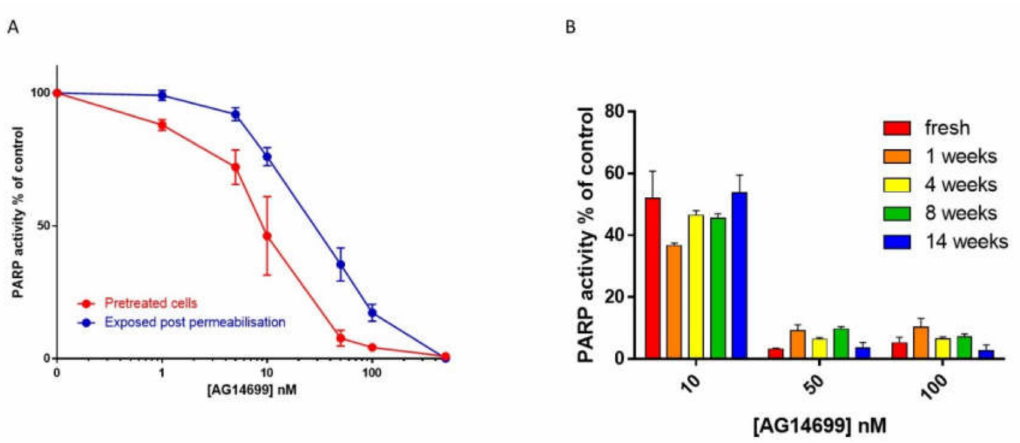
Figure 2. Inhibition of cellular poly (ADP-ribose) polymerase (PARP) activity. ( A ) PARP inhibition by increasing concentrations of AG14699 (rucaparib) following pre-treatment of L1210 cells (30 min) with drug prior to harvesting (red symbols and line) compared with drug added to the permeabilised cells in the reaction mixture (blue). Data are the mean and SD of three replicates from a representative experiment. ( B ) Stability of PARP inhibition by rucaparib with storage. Cells were exposed to rucaparib for 30 min prior to harvesting and cryopreservation. PARP activity was measured by 32 P NAD + incorporation. Previously unpublished